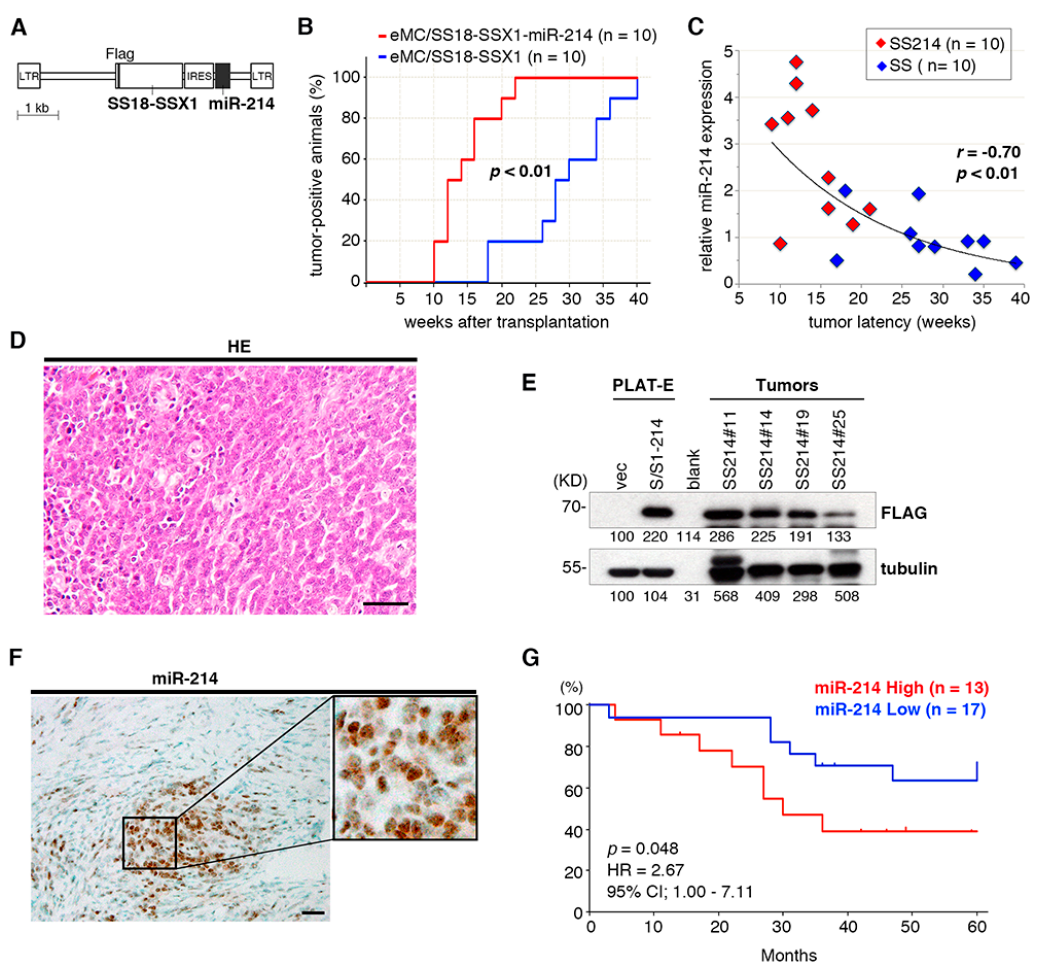
Figure 4. miR-214 cooperates with SS18-SSX1 in synovial sarcoma development. ( A ) Schematic of pMYs-SS18-SSX1-IRES-miR-214/miR-199a-2. ( B ) Cumulative incidences of synovial sarcoma with or without miR-214 . Significance was examined by log-rank test. ( C ) Pearson’s correlation analysis shows inverse correlation between miR-214 expression and disease latencies. ( D ) Histology of synovial sarcoma expressing both SS18-SSX1 and miR-214 . Scale bar indicates 50 μ m. ( E ) Immunoblotting of FLAG-SS18-SSX1 in tumor tissue shows no significant difference in expression between sarcomas with and without miR-214 . ( F ) In situ hybridization of miR-214 shows sarcoma cell-specific expression of miR-214. Inset clarifies nuclear and cytoplasmic accumulation of miR-214. Scale bar indicates 50 μ m. ( G ) Kaplan – Meier survival curves show that increased expression of miR- 214 is associated with poor prognosis in human synovial sarcoma cases.